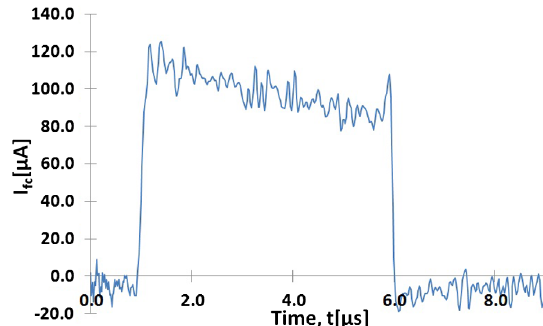
FIG. 18. Reconstructed beam profile with a duration of 5 (cid:1) s .